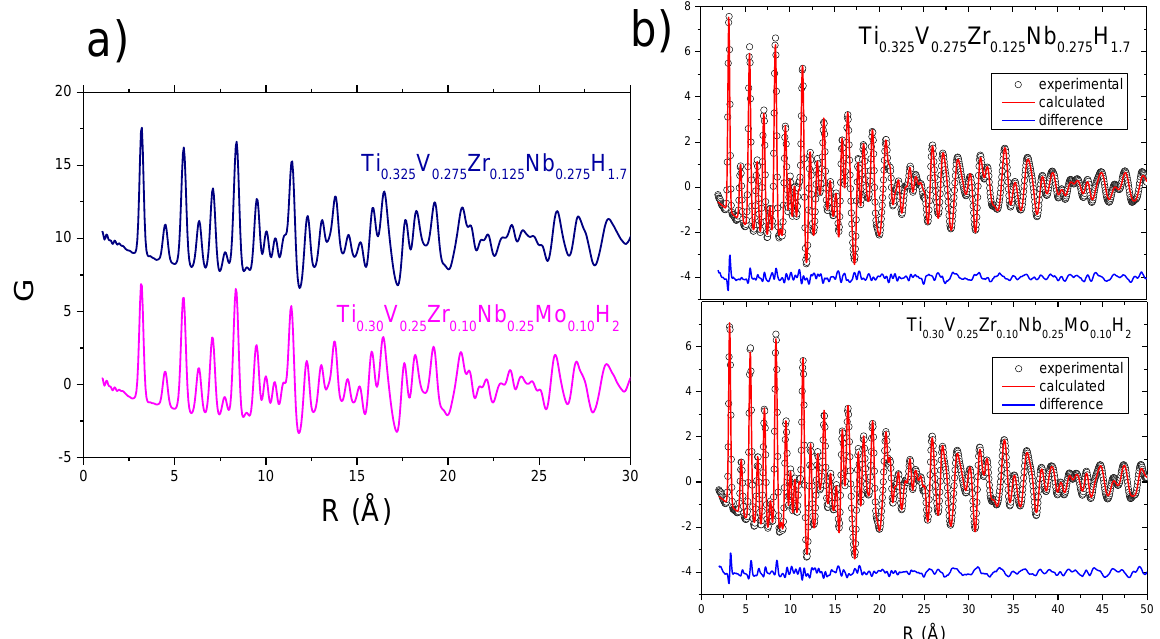
Figure 5. ( a ) PDF data of the Ti 0.325 V 0.275 Zr 0.125 Nb 0.275 H 1.7 and Ti 0.30 V 0.25 Zr 0.10 Nb 0.25 Mo 0.10 H 2 hydrides and ( b ) comparisons of the measured PDFs and their fits based on undistorted fcc random structure for both hydrides. The PDF data of Ti 0.325 V 0.275 Zr 0.125 Nb 0.275 H 1.7 and Ti 0.30 V 0.25 Zr 0.10 Nb 0.25 Mo 0.10 H 2 hydrides